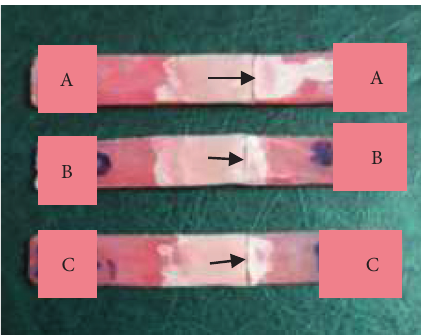
Figure 4: Nylon denture base was repaired by (a) microwave heat- polymerized, (b) Ivomate autopolymerized, and (c) light-poly- merized samples. The black arrows indicate the fracture